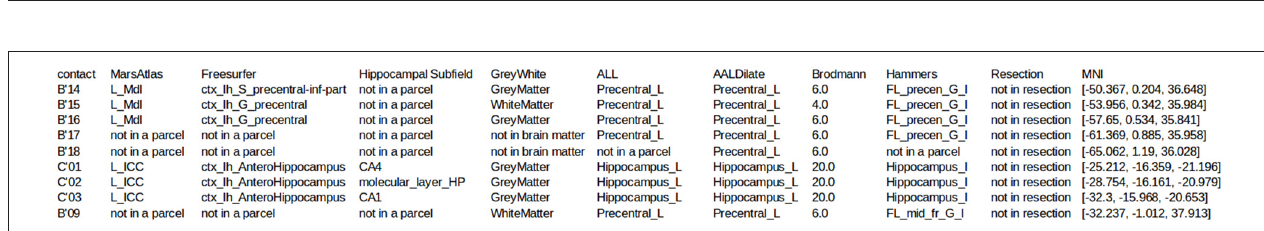
FIGURE 6 | Example of electrode contact labels generated by IntrAnat. Each contact is labeled in all anatomical atlases.